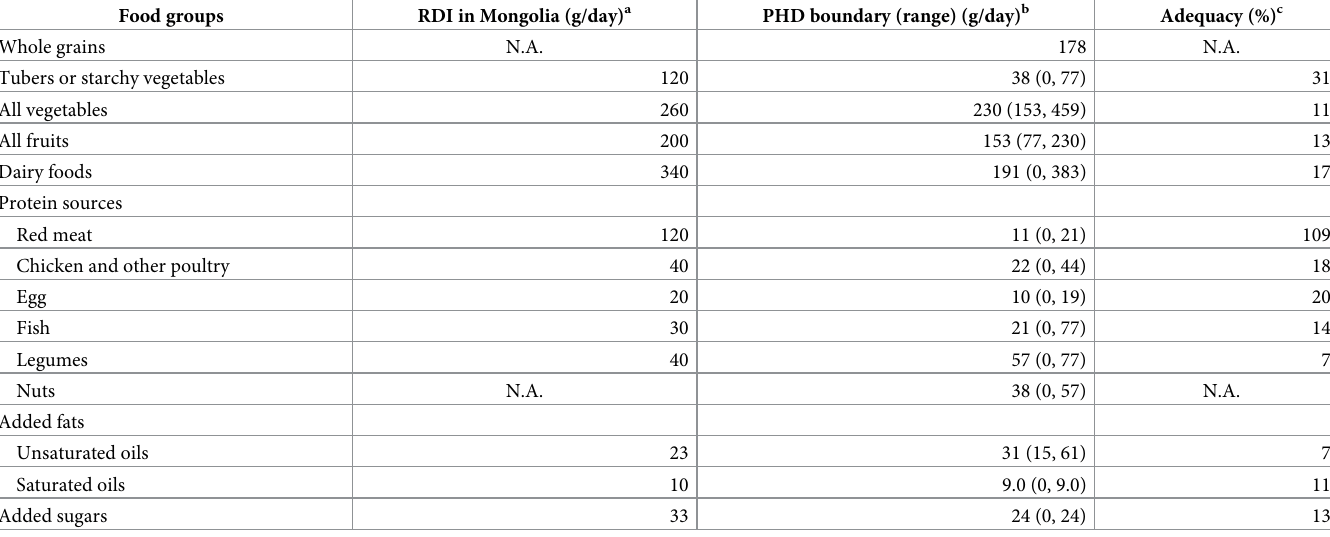
Table 5. Recommended dietary intake in Mongolia compared with the health boundary of the planetary health diet. Food